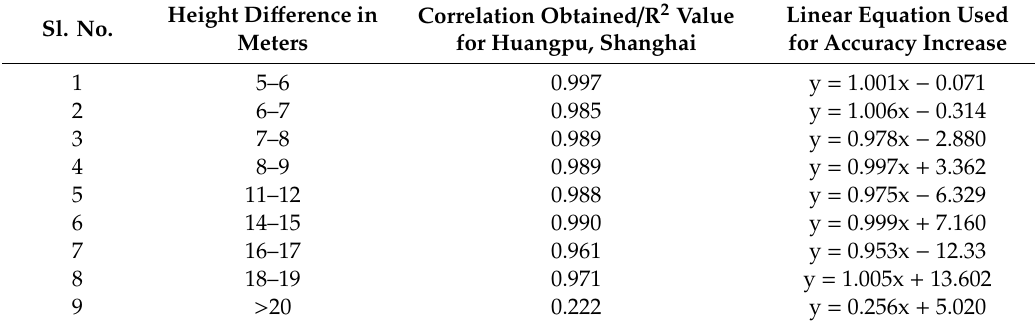
Figure 5. Sample of foundation 3D model generated from AW3D-30 data and classified according to the elevations, Shanghai (green colour represents low-rise buildings, brown colour represents medium-rise buildings, dark brown represents high-rise buildings). Table 5. Correlation values for different ranges and linear equations for accuracy enhancement (Huangpu District, Shanghai) .